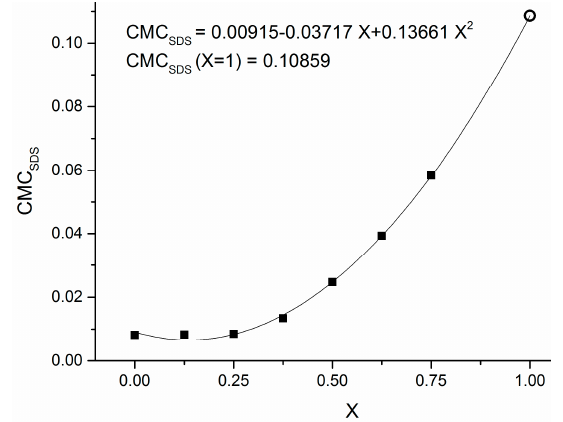
Figure 2. Plot of critical micellar concentration of SDS in a mixture of EG–H 2 O versus the volume fraction x of EG. The solid squares are data taken from Ref. [29], while the hollow circle is an extrapolated value obtained using the parabolic fitting curve for x = 1.